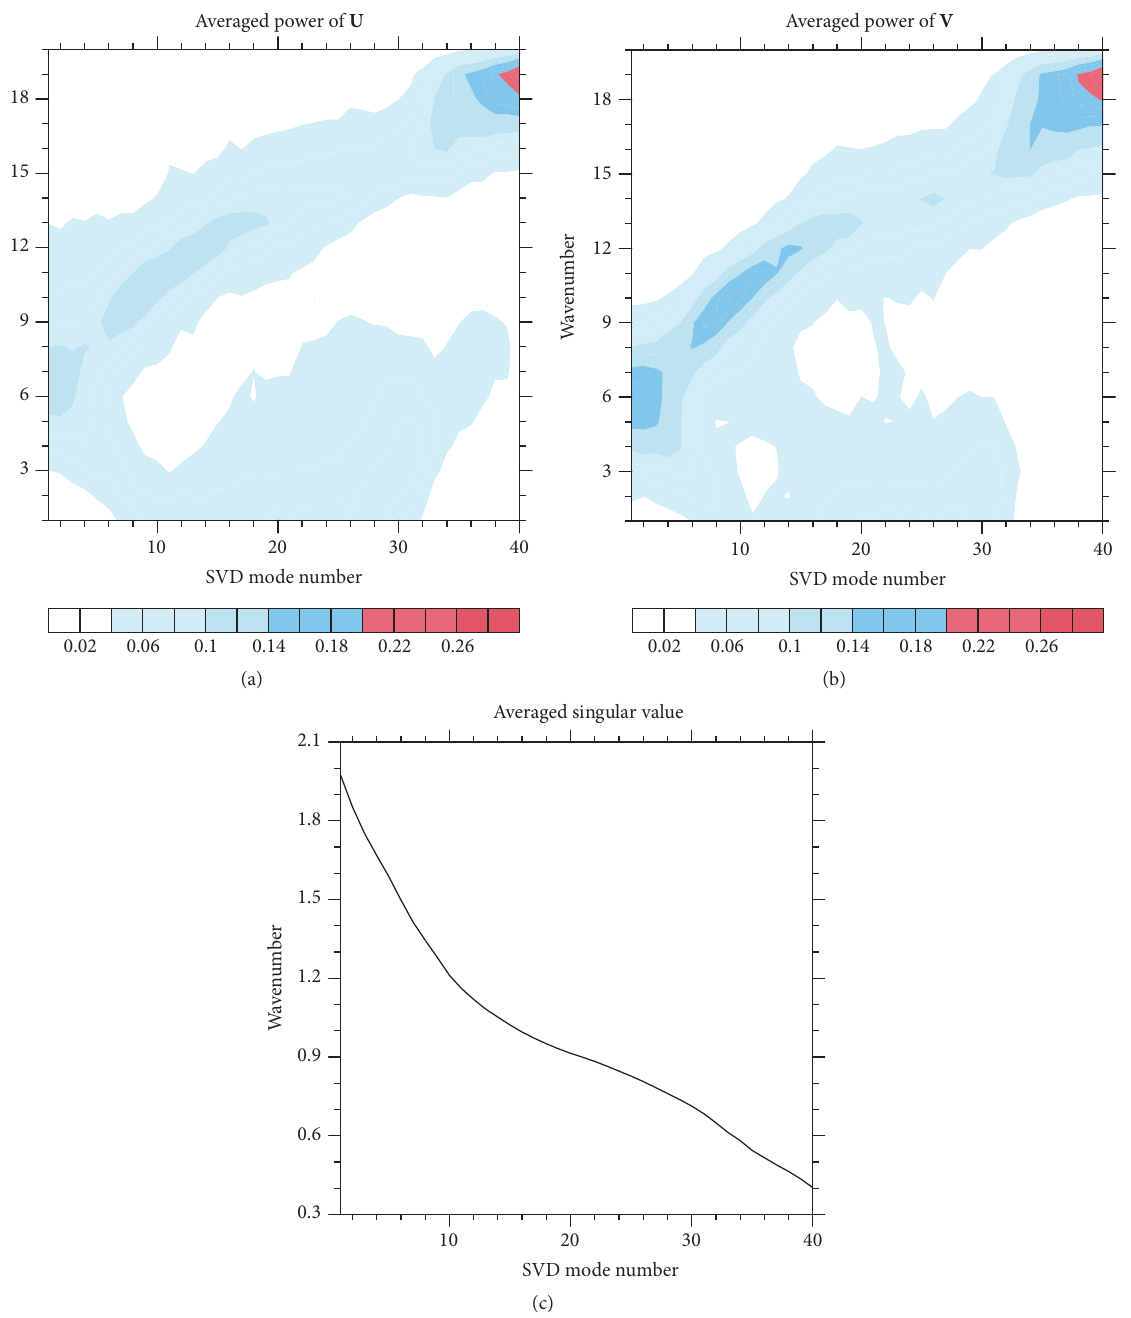
Figure 5: The time averaged (from day 0 to day 10) power spectrum analysis in (a) the left and (b) the right singular vectors and (c) the corresponding singular values in the TLM M 𝑛 that evolves a perturbation at a time step 𝑡 𝑛 to 𝑡 𝑛+1 . Note a singular value on the 𝑦 -axis right panel is a linear perturbation growth rate when the perturbation is grown linearly for 12 hours.